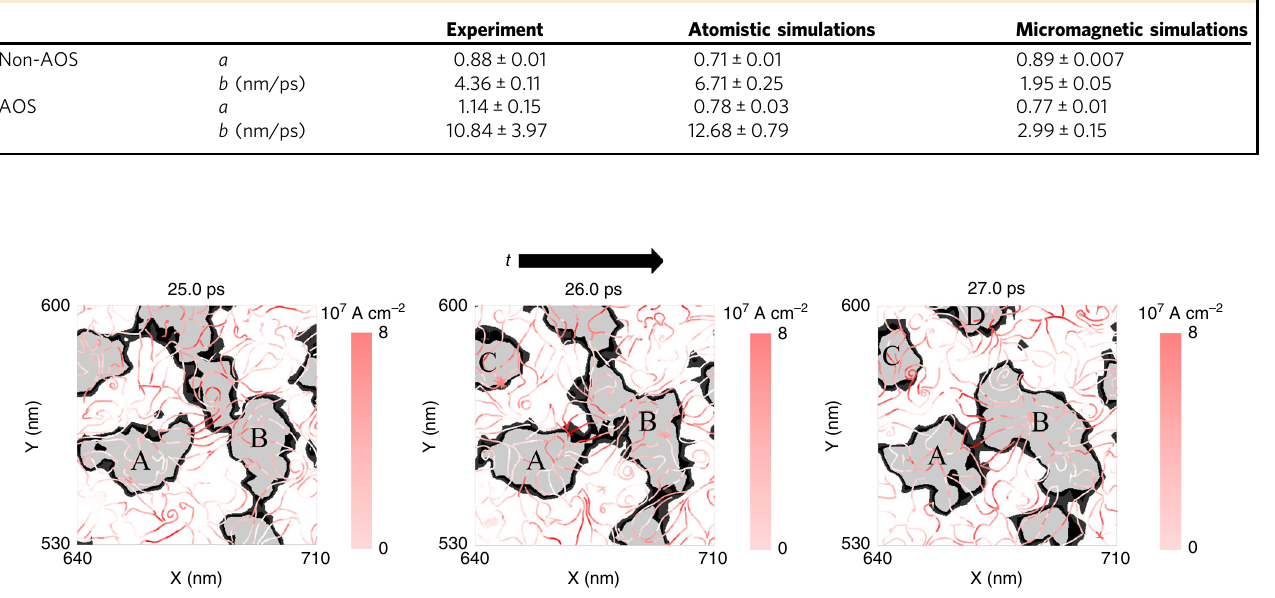
Fig. 8 Large transfer of angular momentum. The snapshots show the evolution of magnon drops, including merger and break-up. The black areas represent magnon drop perimeters (| m z | < 0.2) and the white and grey areas indicate that the perpendicular-to-plane magnetisation is preferentially parallel or antiparallel to the applied fi eld. The pink-shaded curves represent EFSCs expressed as equivalent 100% spin polarised charge current. The streamlines indicate the instantaneous transfer of perpendicular-to-plane angular